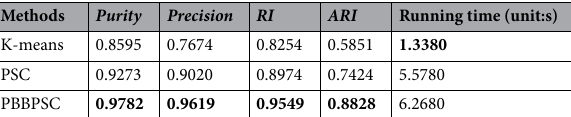
Table 4. Evaluation parameters of the three clustering methods. Significant values are in bold.